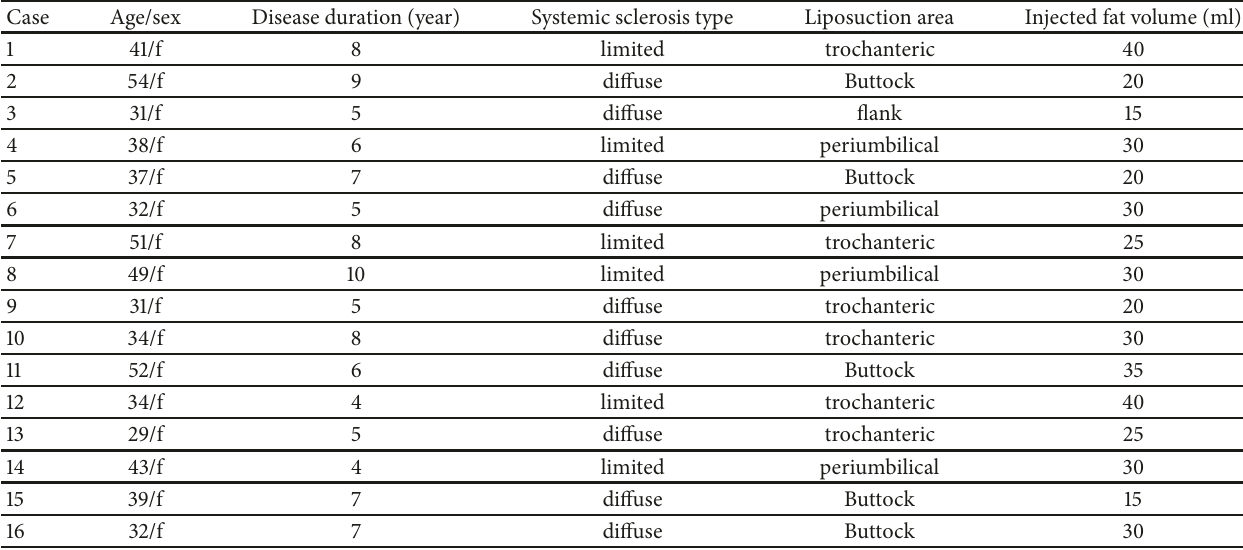
Table 2: Baseline demographic, clinical, and therapeutic characteristics of